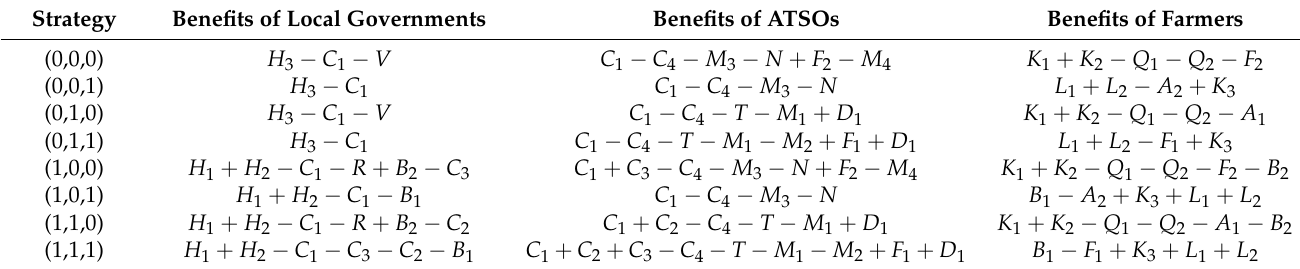
Table 1. The tripartite game income